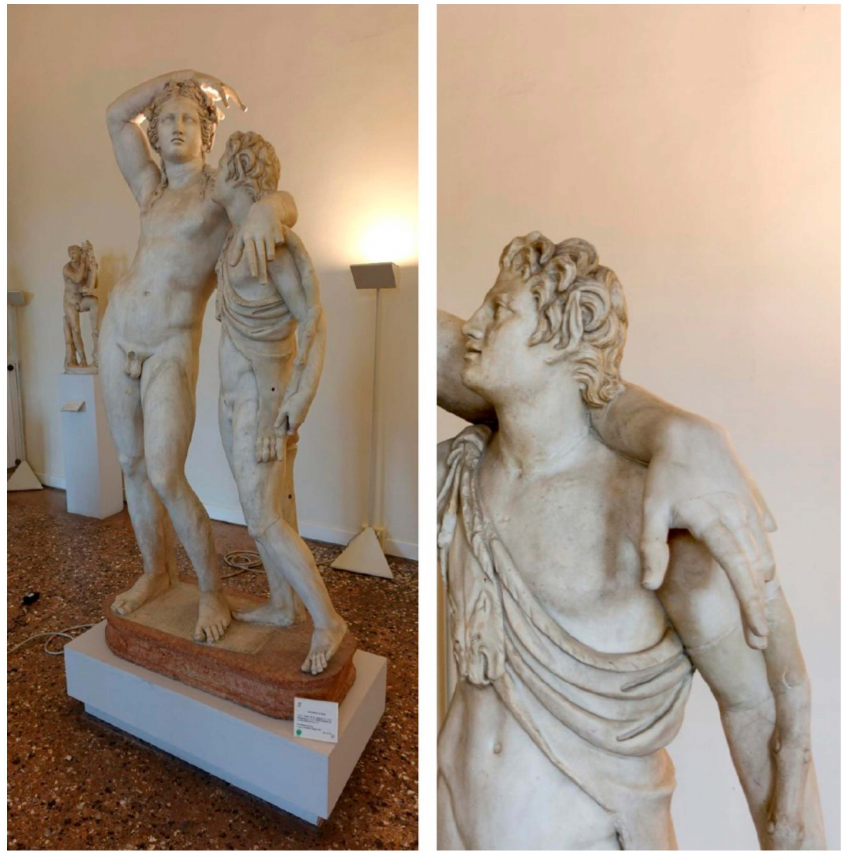
Figure 9. ( left ) The “Dionysus with Satyr.” ( right ) A detail of the marble